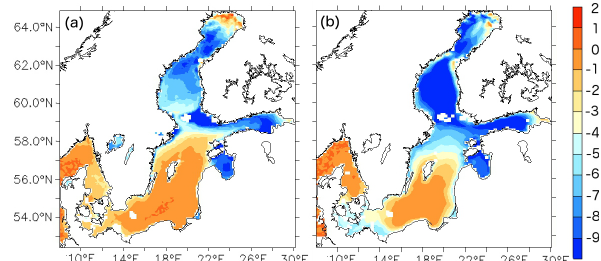
Fig. 20. Leading EOFs of (a) observed and (b) modeled seasonal mean ice concentrations Figure 20. Leading EOFs of (a) observed and (b) modelled sea- [%]. sonal mean ice concentrations [%].